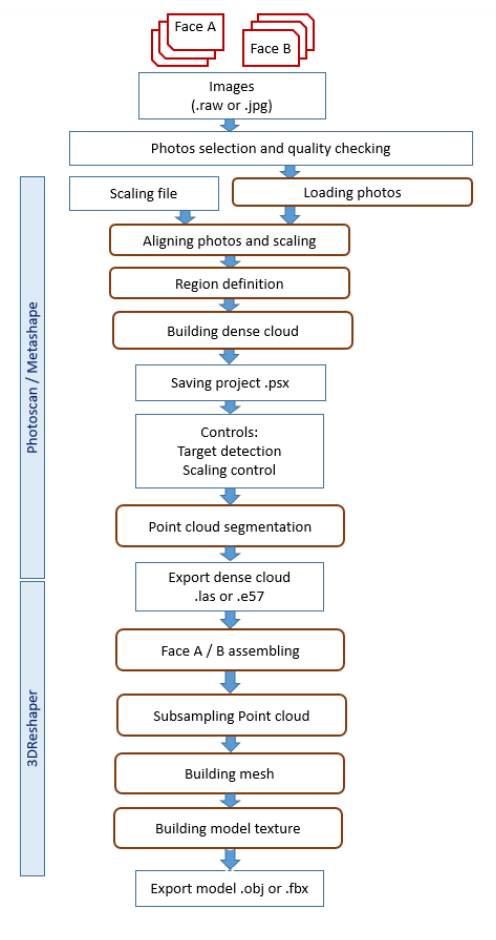
Figure 7: Workflow with assembling of two scaled faces using best-fit algorithm in 3DReshaper .